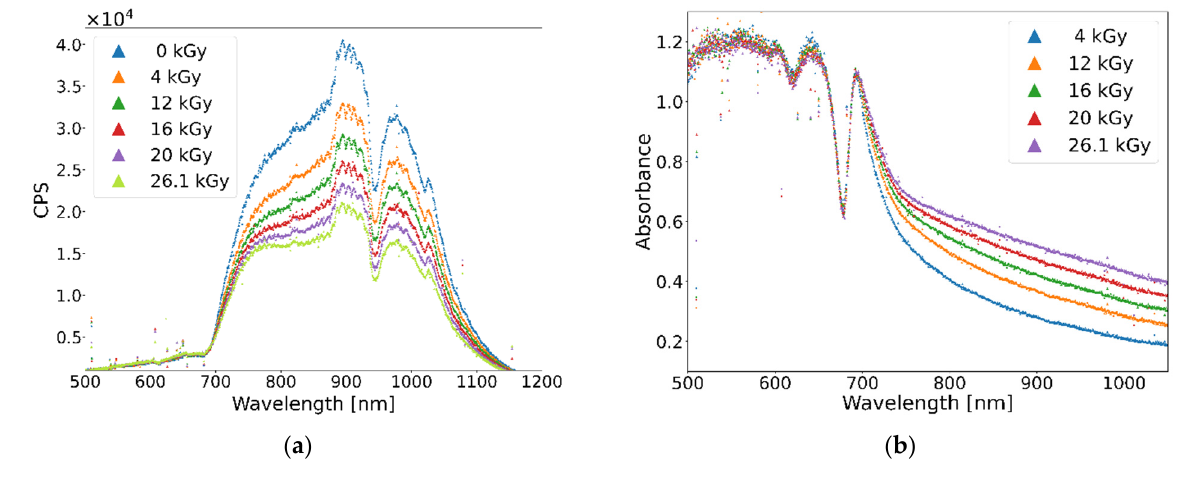
Figure 3. Reflection ( a ) and absorbance spectra ( b ) of HDV-2 gafchromic film exposed to different doses from a 19.9 MeV proton beam. The dose was measured by means of an ionization chamber used for the calibration of the dosimeter.